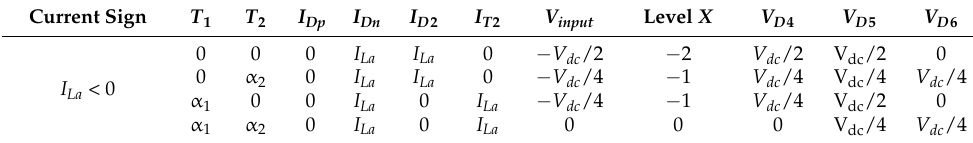
Table 3. The switches’ states and the average values of the current and voltage for I La < 0. Current